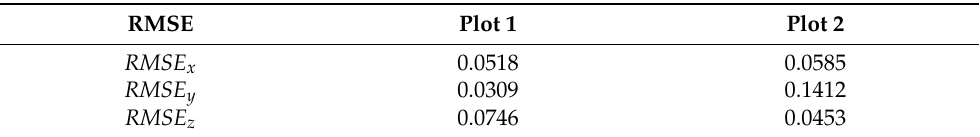
Table 2. Root mean square error of all 175 checkpoints recorded by a total station and an RTK GNSS terrestrial receiver.